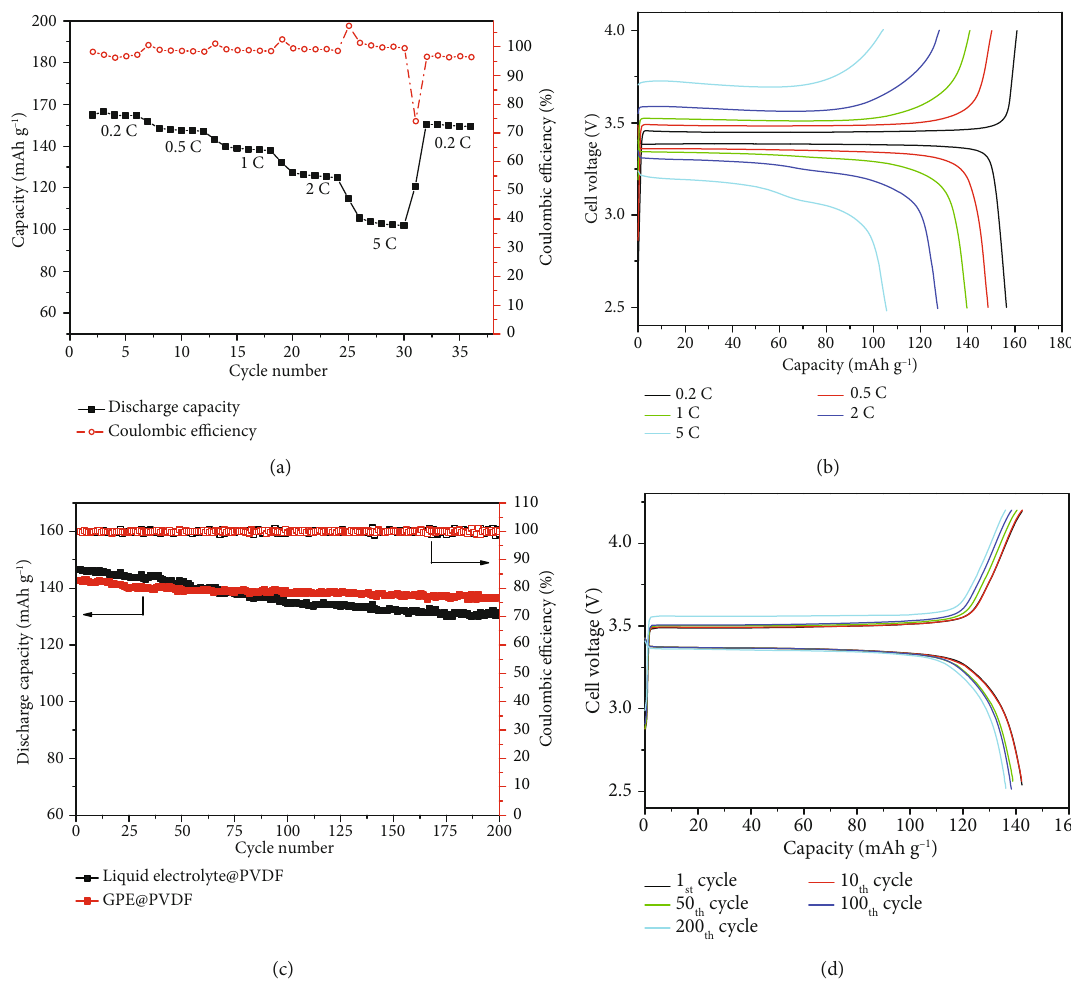
Figure 7: (a) Rate performance and (b) typical charge − discharge curves at various rates of GPE (10% polymer content) @ PVDF membrane cells; (c) cycling performance of liquid electrolyte @ PVDF cells and GPE (10% polymer content) @ PVDF membrane cells at 1 C; (d) typical charge − discharge curves of GPE (10% polymer content) @ PVDF membrane cells at 1